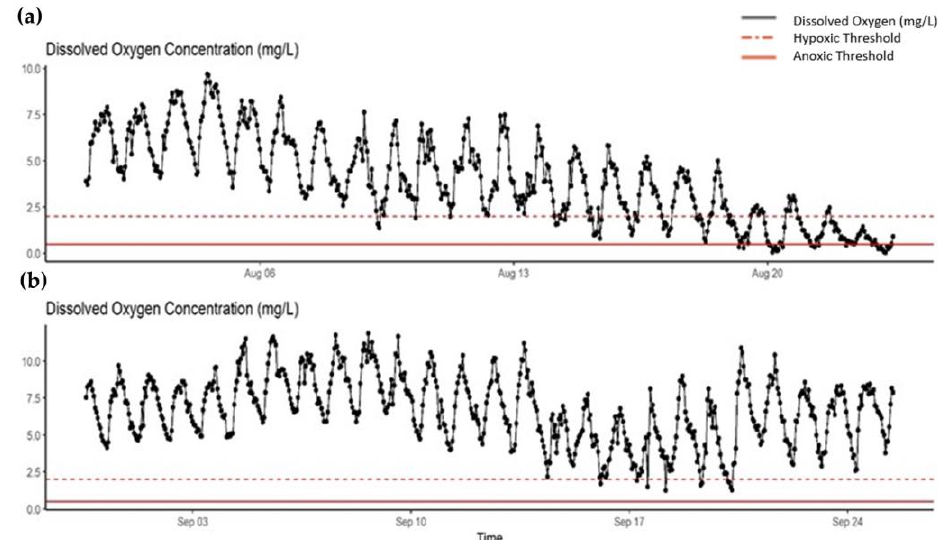
Figure 3. Dissolved oxygen levels collected from underneath the NASA causeway just outside the ITL impoundments reached hypoxic and anoxic levels leading to a localized fish kill in August 2018. ( a ) Dissolved oxygen levels from 1–23 August 2018. ( b ) Dissolved oxygen levels from 30 August to 25 September